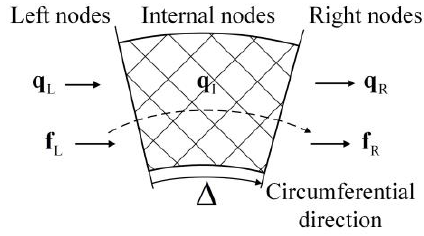
Figure 3. Unit Cell in circumferential direction.